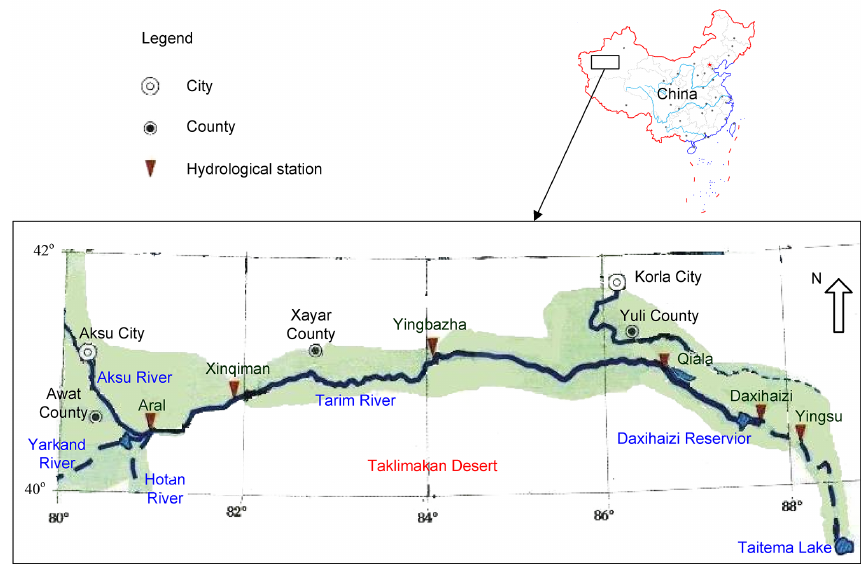
Figure 1. Location of the main stream of the Tarim